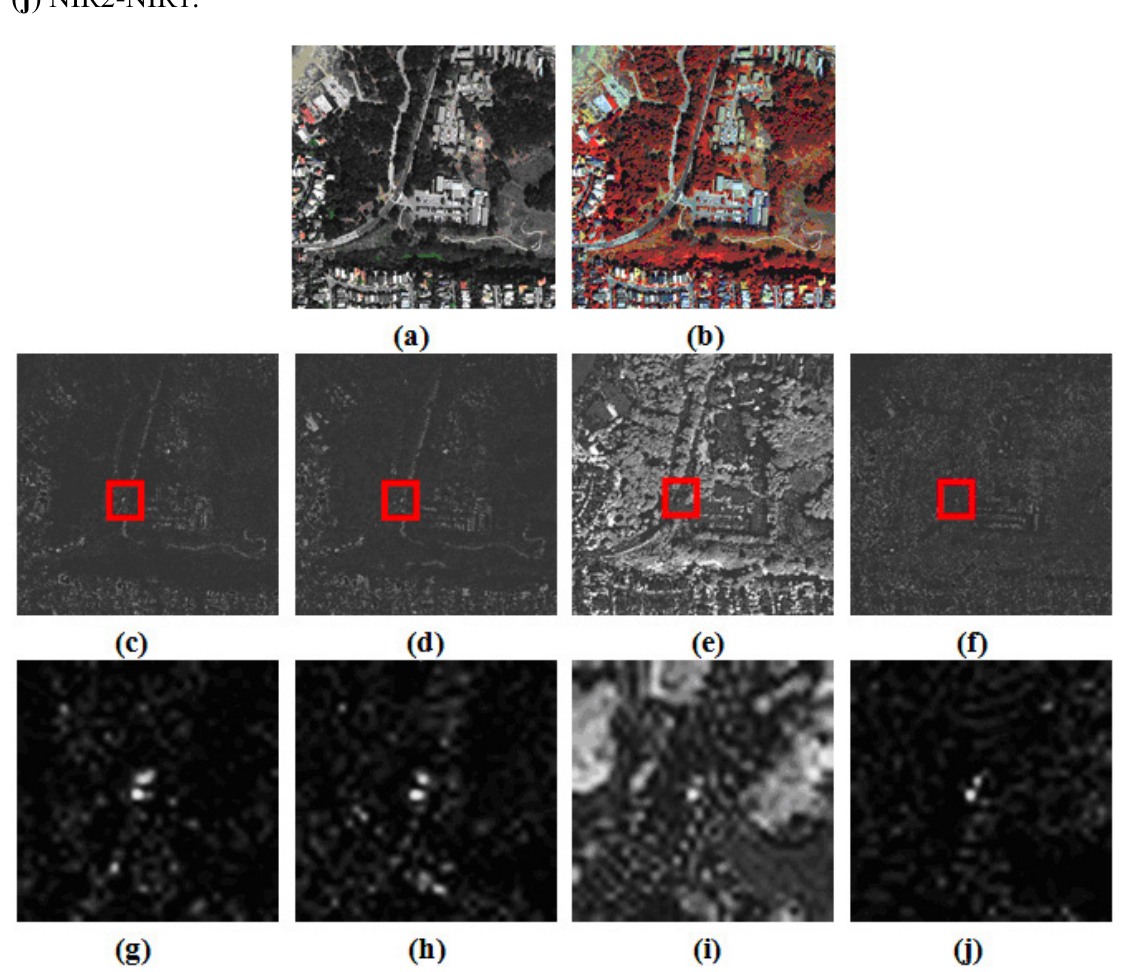
Figure 11. Change detection maps between spectrally-neighboring bands: ( a ) MS1 image; ( b ) MS2 image; ( c ) C-B; ( d ) Y-G; ( e ) RE-R; ( f ) NIR2-NIR1, ( g ) C-B; ( h ) Y-G; ( i ) RE-R; ( j ) NIR2-NIR1.